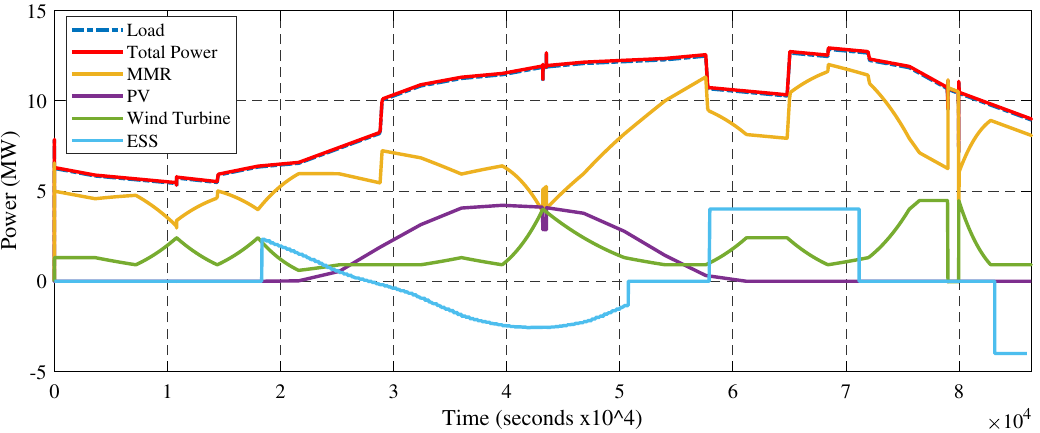
Figure 9. Performance of the HES with proposed EMS.